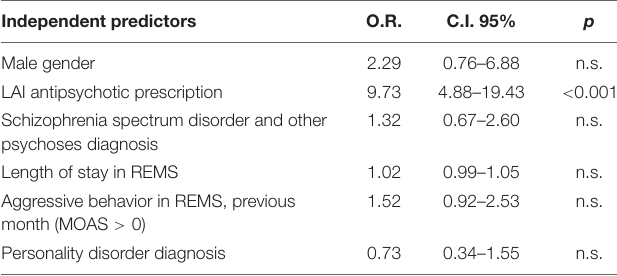
TABLE 4 | Binary logistic regression analysis of factors associated with very high-dose antipsychotic prescription (PDD/DDD > 3). Independent